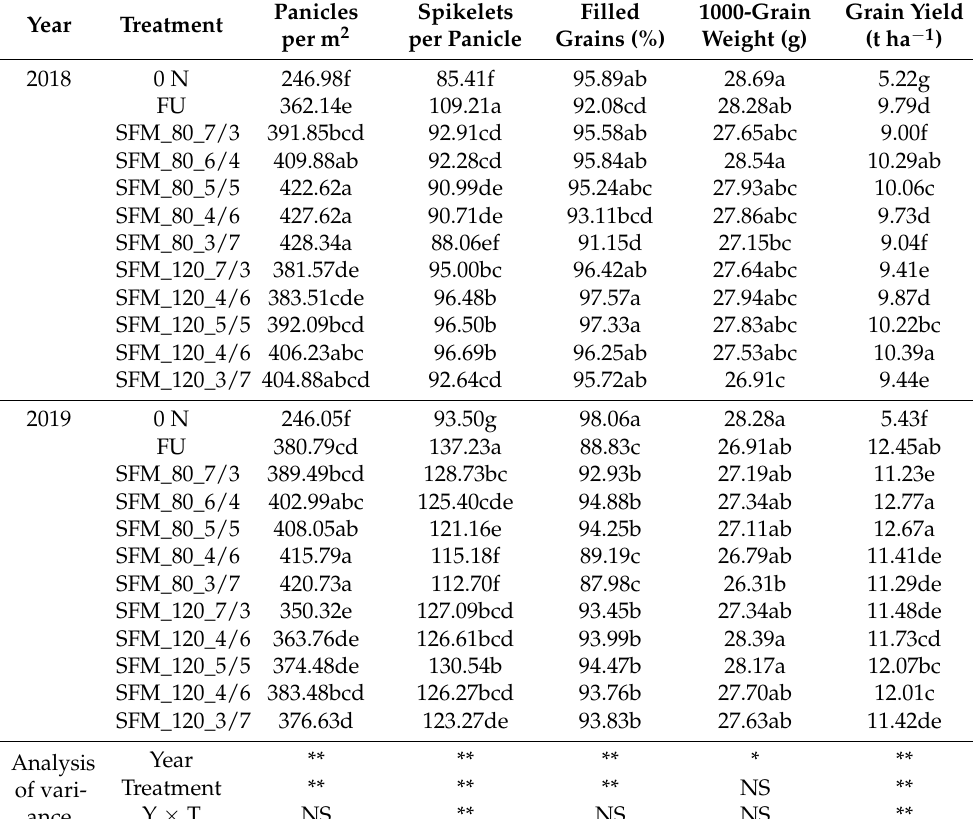
Table 3. Grain yield and its components in different fertilizer treatments of 2018 and